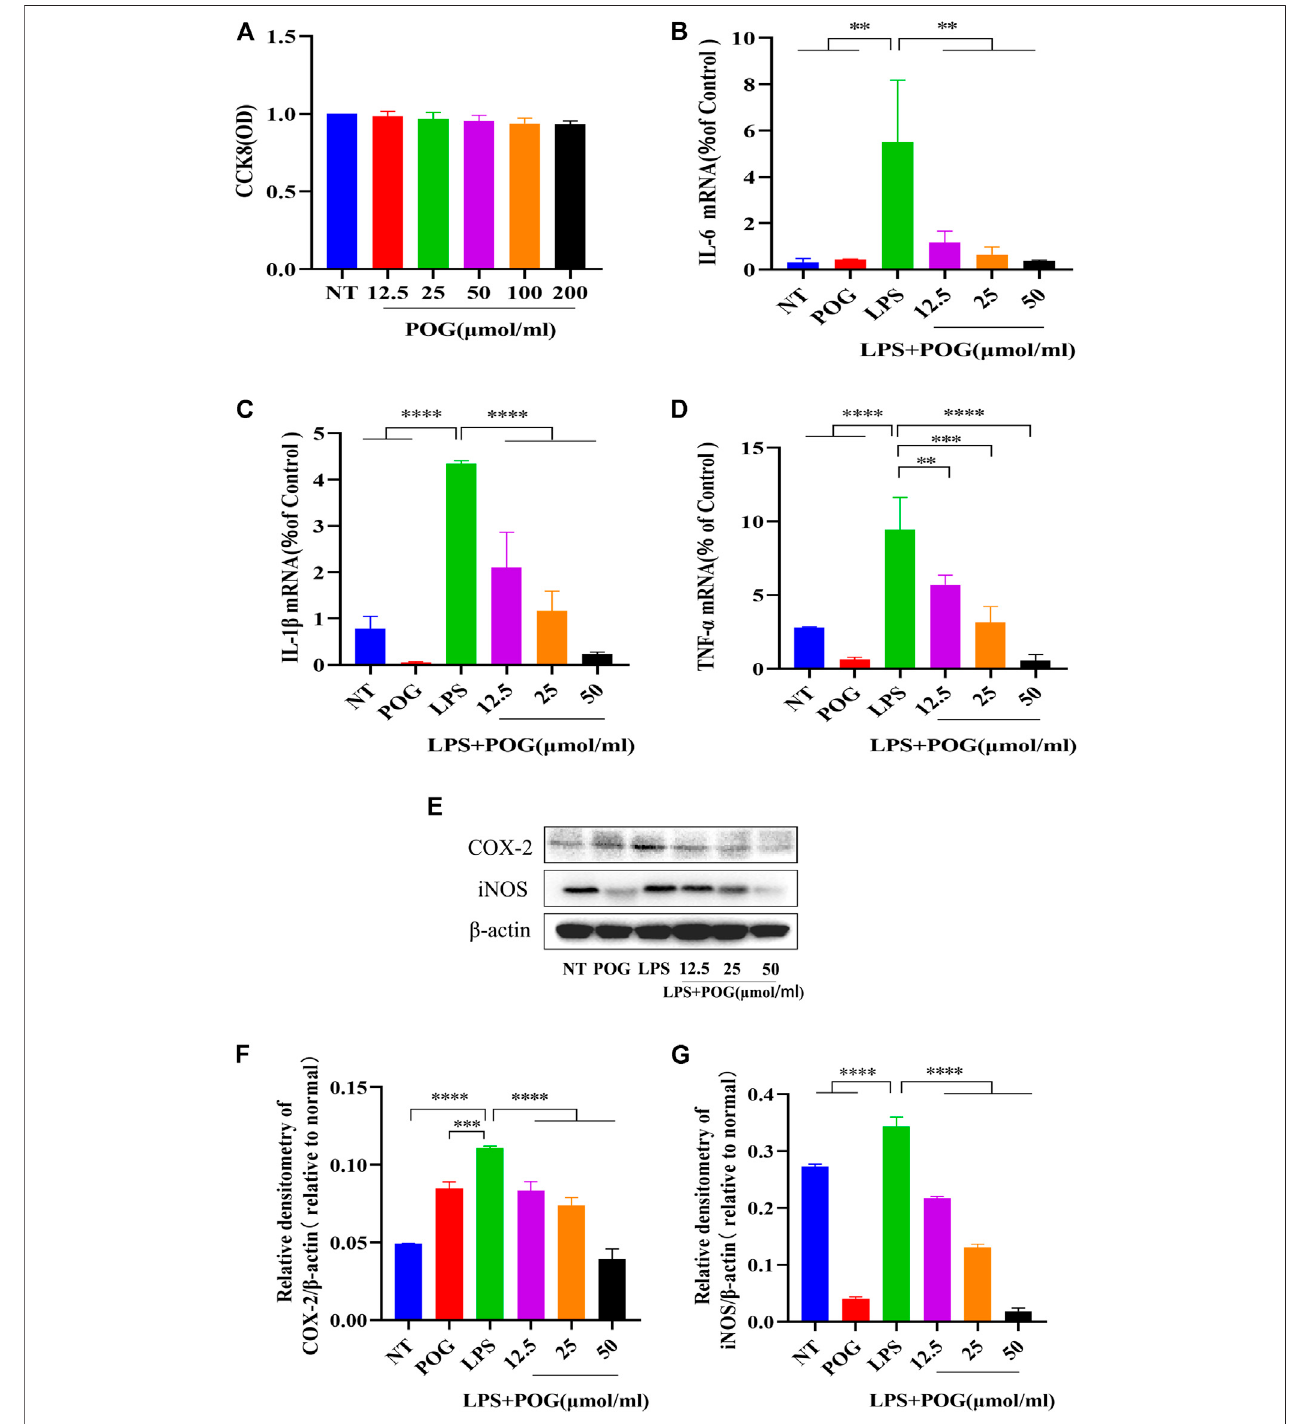
FIGURE 8 | POG treatment suppresses in fl ammatory cytokine expression within LPS-treated RAW264.7 cells. (A) The activity of CCK8 cells was determined to affect RAW264.7 cells within the range of POG (12.5, 25, 50, 100,200 μ mol/L). (B – D) qRT-PCR extraction of cellular mRNA for detecting IL-1 β , TNF- α , and IL-6 expression. (E – G) iNOS and COX-2 protein levels measured through WB assay. Data were means ± SD ( n = 3). *p < 0.05, **p < 0.01, ***p < 0.001, ****p < 0.0001. diseased mice throughout the pathogenesis of the DSS- effect in the treatment of UC model mice. The pathogenic mediated UC mice model and greatly improves mice weight mechanism of UC is still unknown. Many factors can cause maintenance. The fi ndings indicate a dose-dependent POG UC. There is much evidence that immune cells and non-